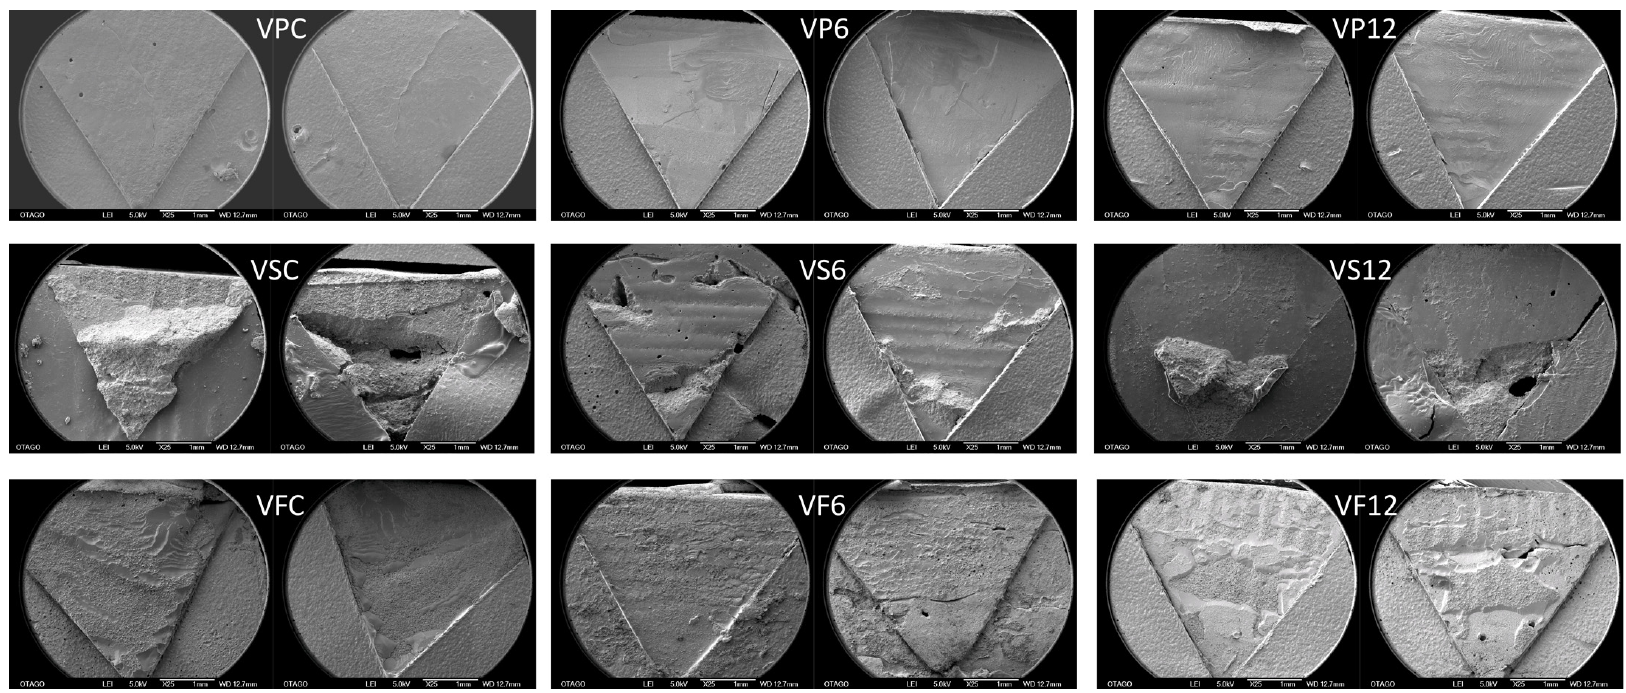
Figure 5. Representative SEM images (×25 magnification) of one specimen per group ( T : Telio CAD, V : Vivodent CAD, S : SR Nexo, F : Ceramage, C : control, 6: 6 months, 12: 12 months). on the left-hand side of each slide, the composite is shown, on the right-hand side of each slide, CAD material is shown.